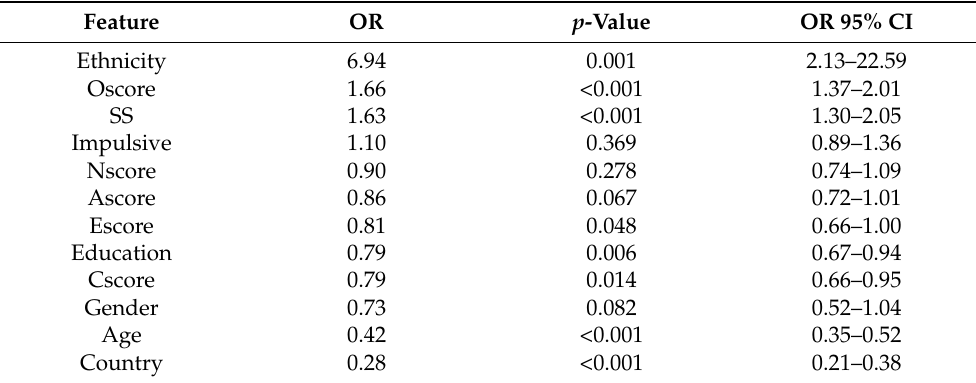
Table 4. LR model odds ratios (OR), p -values and 95% confidence intervals (CI). Features are listed in order of importance as determined by the OR value. p -values of variables with questionable significance are in